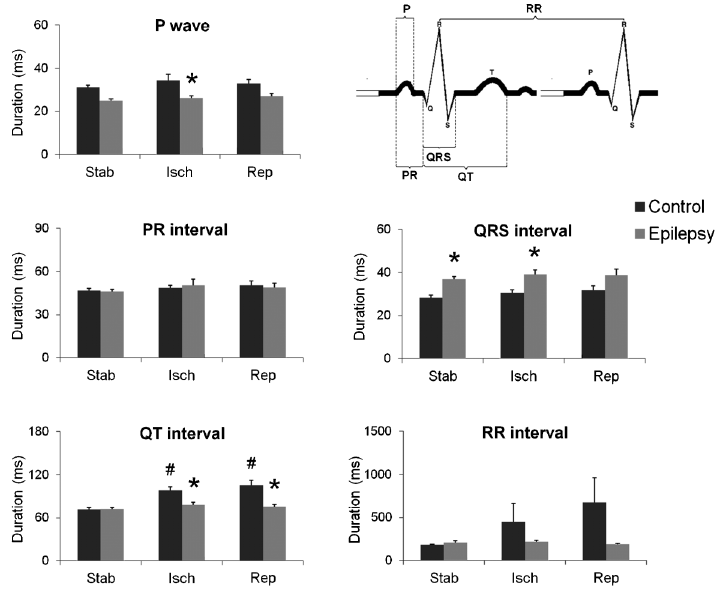
Figure 2. Duration of P wave, and PR, QRS, QT and RR intervals in rats from the control and epilepsy groups during stabilization (Stab), ische- mia (Isch) and reperfusion (Rep). *P , 0.05, compared to the control group; # P , 0.05, com- pared to the stabilization period (ANOVA fol- lowed by Bonferroni’s post hoc